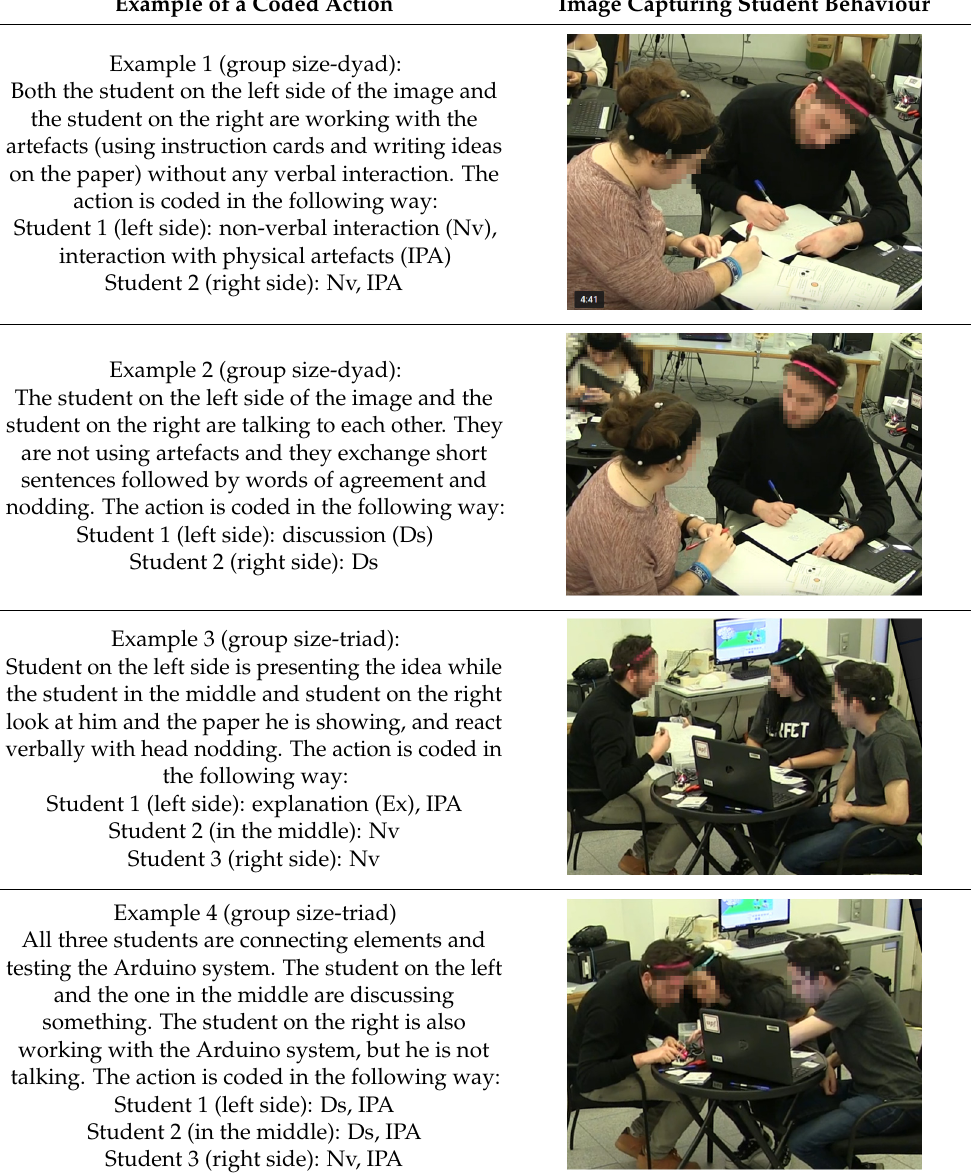
Table 2. Examples of on-task actions. Example of a Coded Action